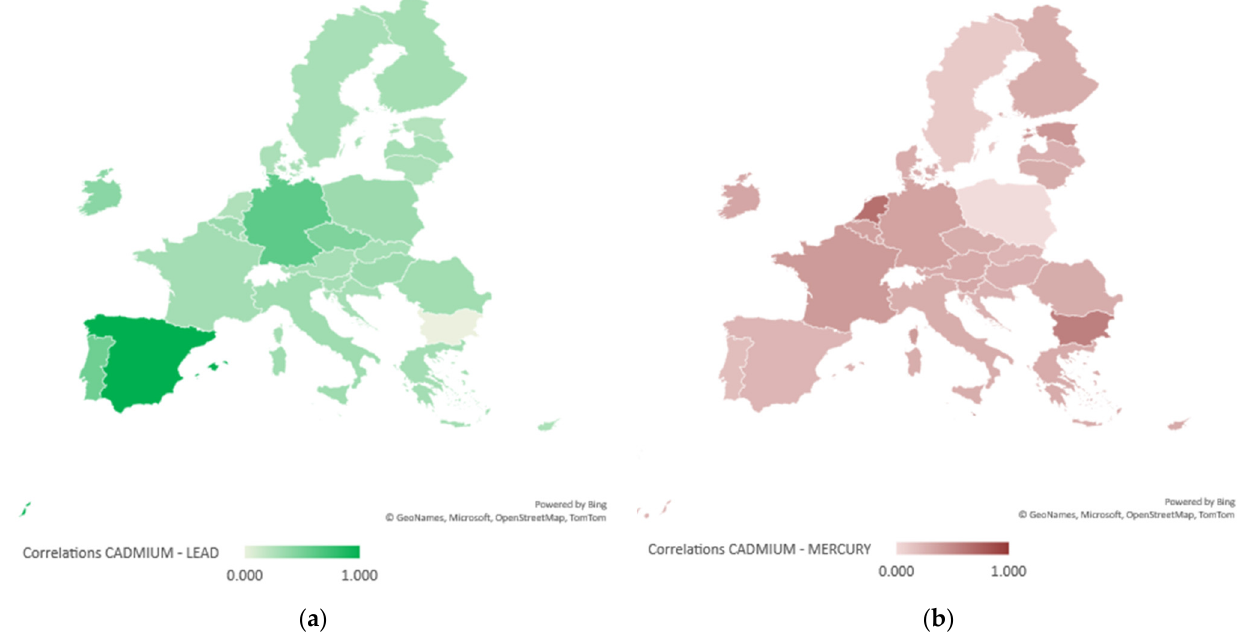
Figure 5. Dispersion of general model correlations by evaluating national models: ( a ) Dispersion for cadmium-lead pollution reduction policies; ( b ) Dispersion for cadmium–mercury pollution reduc- tion policies.